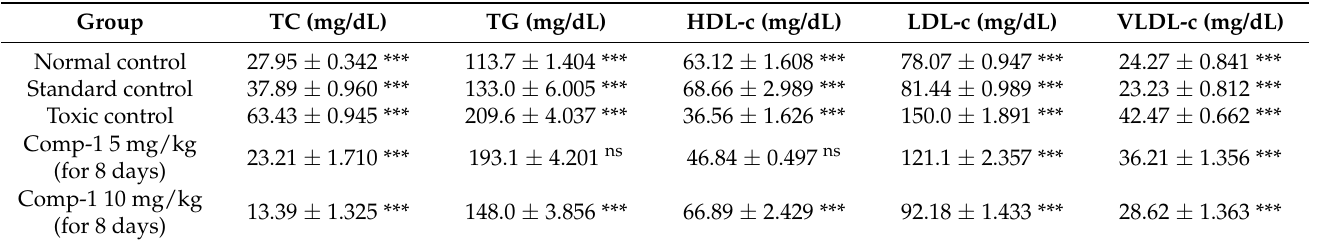
Table 3. Effects of Comp-1 on biochemical parameters of lipid profile in 5-FU-induced toxicity in rats.